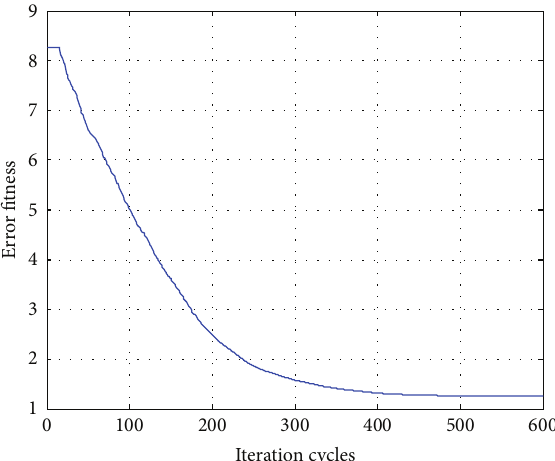
Figure 20: Convergence profile for OHS in case of FIR HP filter of order